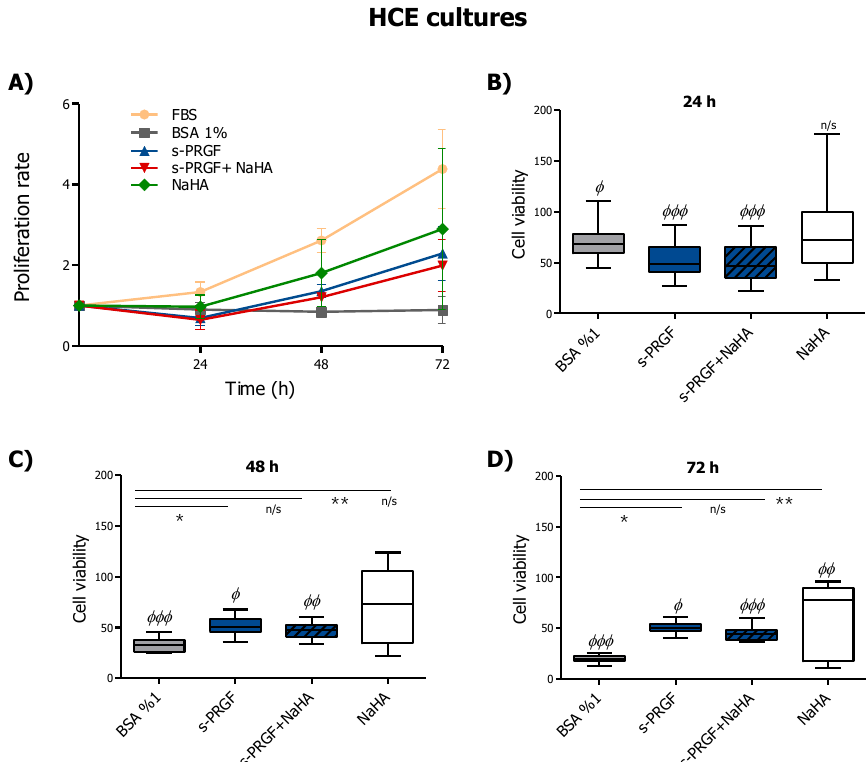
Figure 2. Effect of s-PRGF, alone or combined with NaHA, on the ( A ) proliferation and ( B – D ) viability of human corneal epithelial (HCE) cells. Cultures were exposed for 24, 48, and 72 h to 10% FBS; 45% s-PRGF; 45% s-PRGF and 0.1% NaHA (combined treatment); 0.1% NaHA; and 1% BSA as a negative control. Proliferation results are expressed as proliferation rate ± standard deviation of viable cells with respect to viable cells at t = 0. Viability results are expressed as percentages versus that with FBS (100% viability). Statistically significant differences with respect to BSA (*) or to FBS ( Φ ) (* p < 0.05; ** p < 0.01; Φ p < 0.05; ΦΦ p < 0.01; ΦΦΦ p < 0.001; n/s, not significant. Kruskal–Wallis test, Dunn test with Bonferroni correction to Multiple